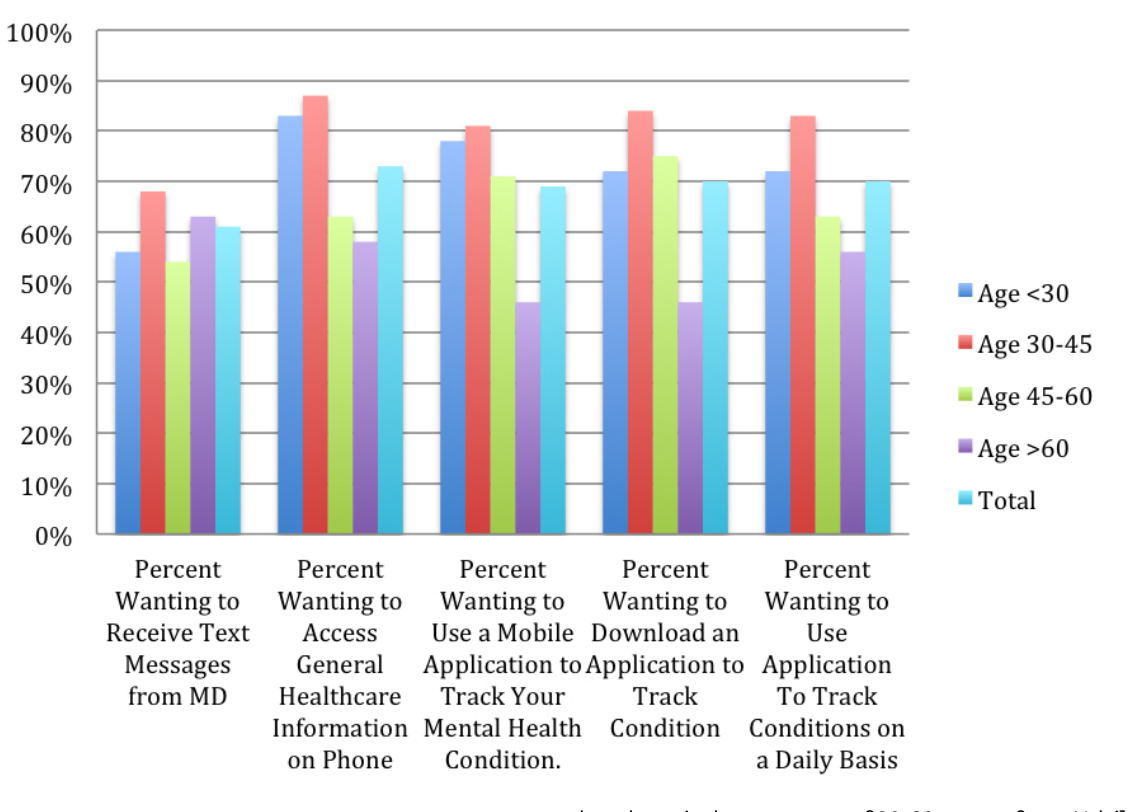
Figure 1. Patients' willingness by age to monitor mental health conditions on